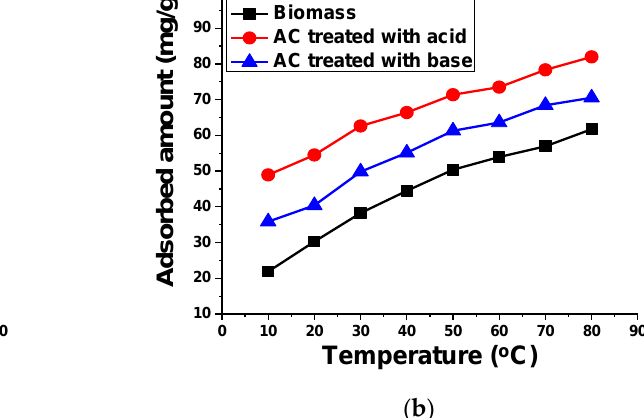
Figure 12. Effect of temperature on the adsorption of 50 mL ( a ) 100 mg/L TB and ( b ) 50 mg/L XO using 0.1 g biomass and AC treated with acid and base for 60 min at 140 rpm.